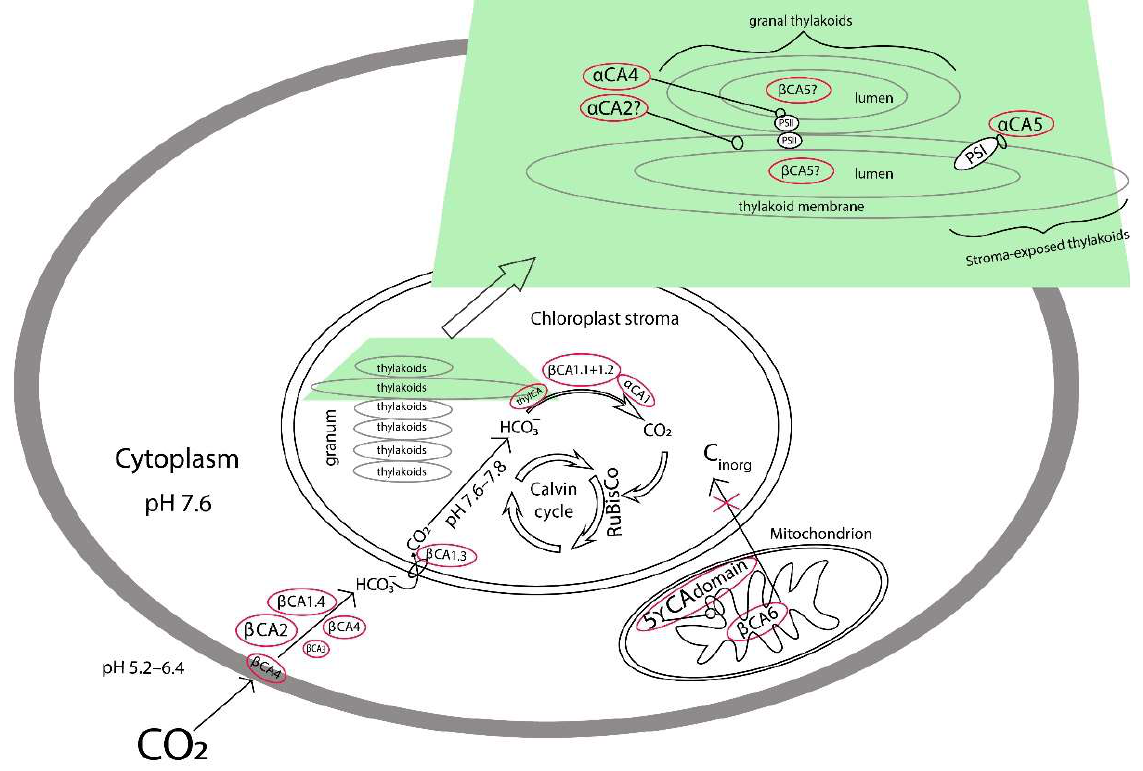
Figure 8. The hypothetical scheme of CAs positions and cooperative participation of CAs located in the cytoplasm and CAs located in the chloroplasts in inorganic carbon supply to carboxylation sites in higher plants. Mitochondrial CAs, apparently, are not involved in inorganic carbon supply to chloroplasts.